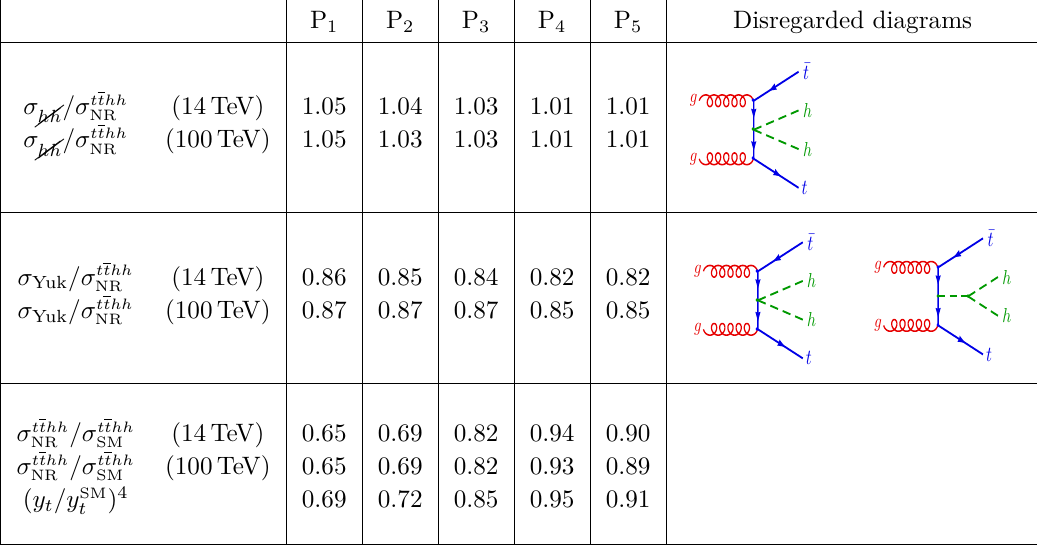
and σ are Yuk hh is the total NR- tthh . NR means we disregarded the SM trilinear Yuk in the MCHM and SM t